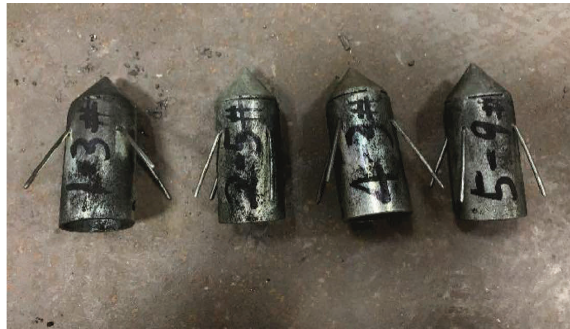
Figure 16: Measuring point device after